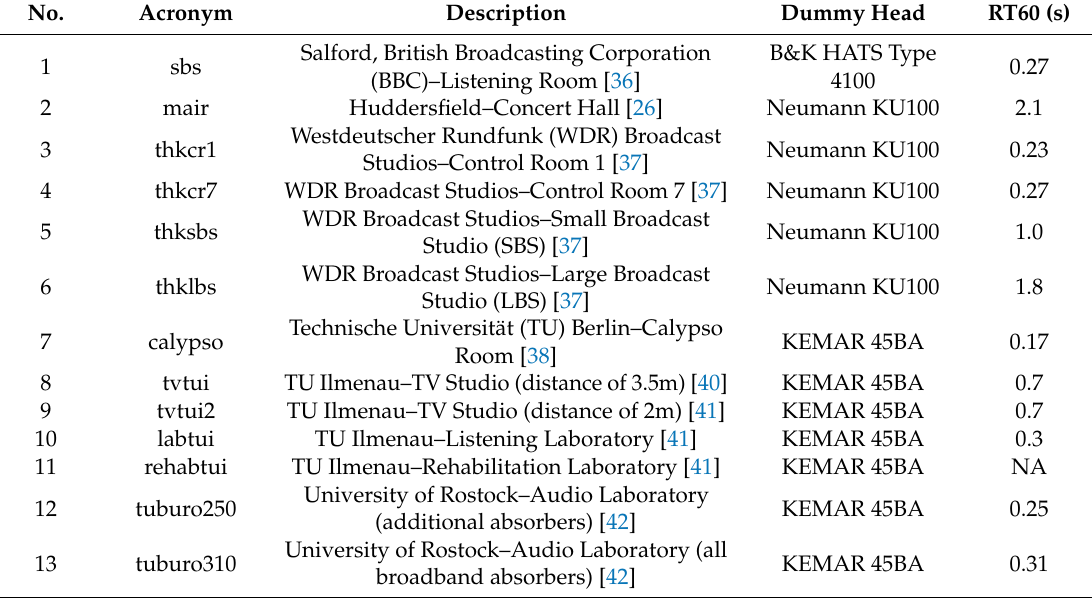
Table 2. Overview of the binaural-room-impulse-response (BRIR) sets used in the study. No.